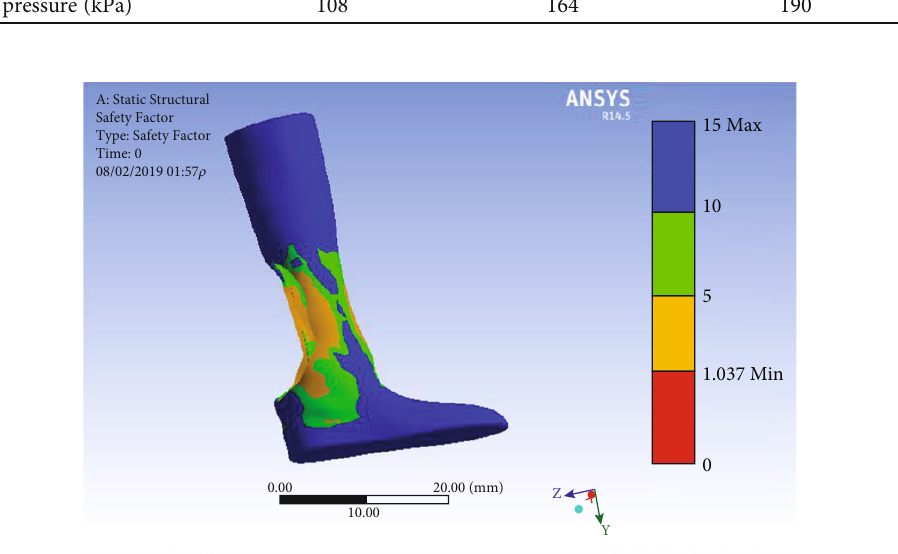
Figure 14: Group A fatigue factor of safety.